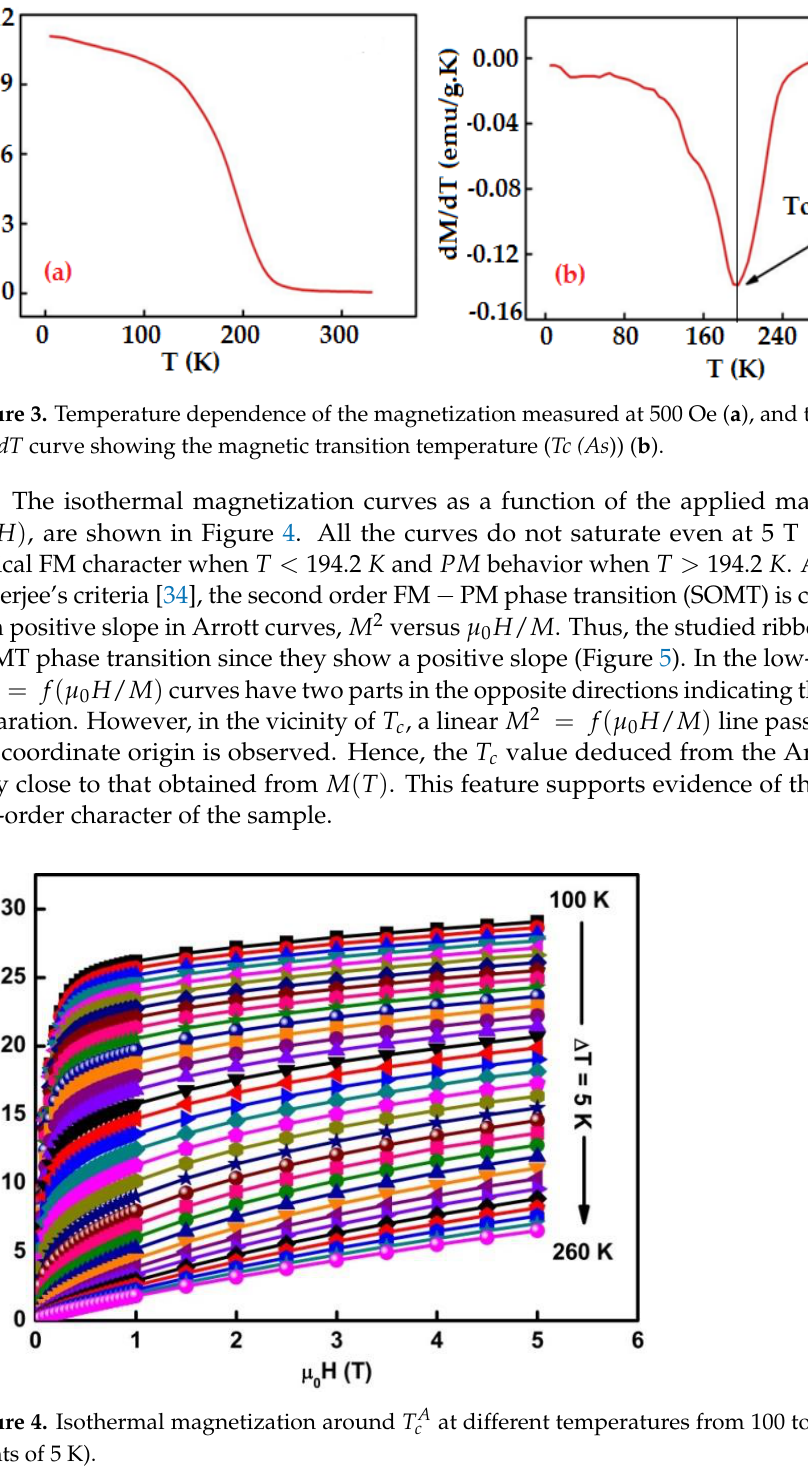
Figure 5. Standard Arrott plot isotherms 𝑀 2 𝑣𝑠. 𝜇 0 𝐻/𝑀 . From 100 to 260 K (increments of 5 K). The vertical shift observed in the magnetization curve may be attributed to the strong AFM interactions in the martensite structure and/or to the short-range AFM magnetic coupling in the Mn-rich areas. Indeed, the rapid solidification leads to struc- tural heterogeneities owing to the temperature difference between the free and wheel surfaces of the ribbons. It is obvious that a small change in the composition or in the elaboration conditions affects the physical properties of the Heusler alloys as shown in Table 1 [2,35,36].